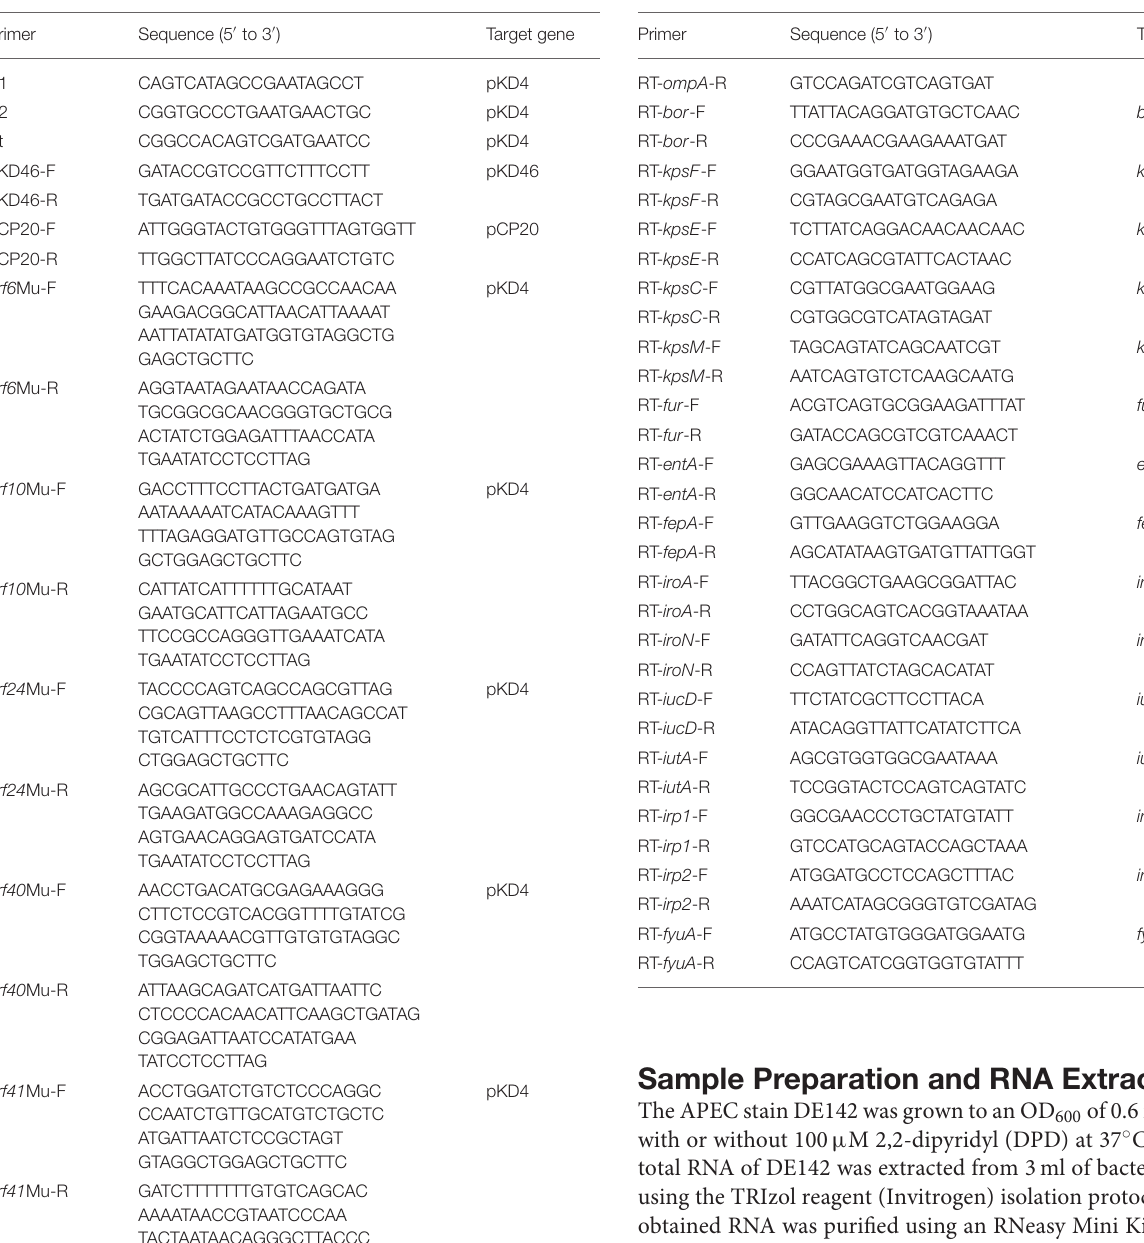
TABLE 2 | Primers used in this